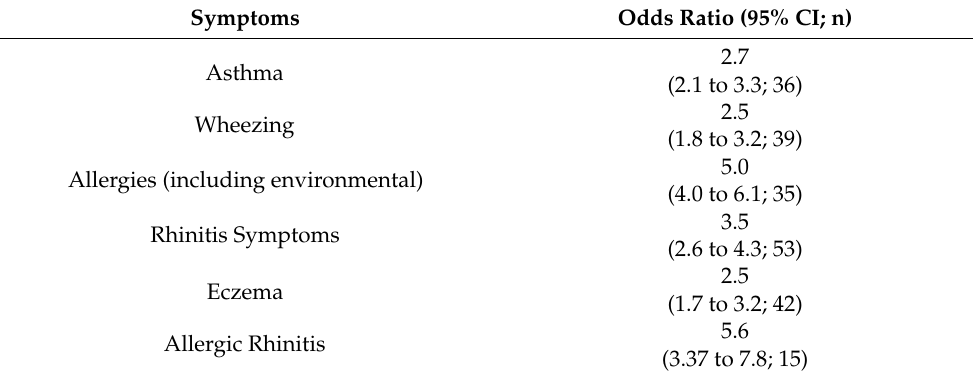
Table 2. Mean age (year) of diagnosis of asthma and allergic comorbidities (95% confidence interval; # children in